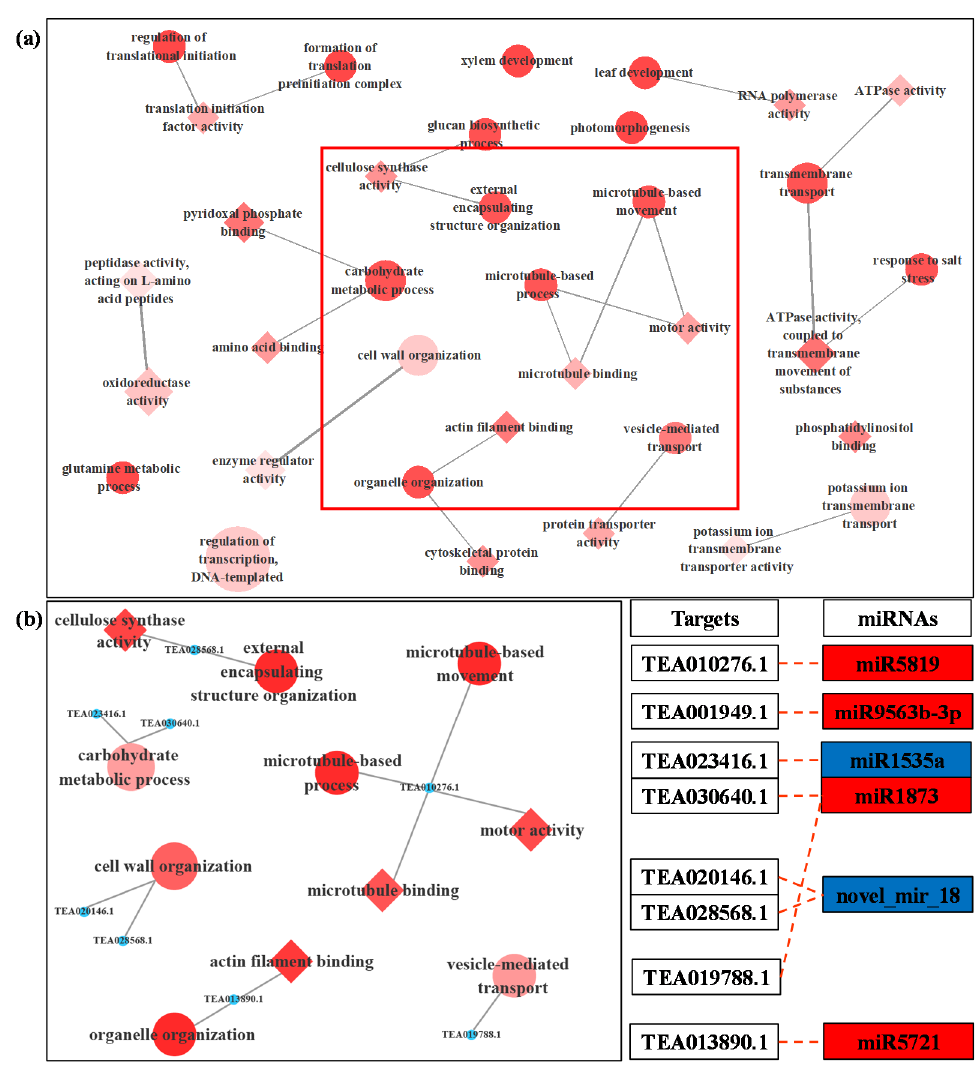
Figure 4. GO-GO network of the targeted genes of DEMs between LT (low-temperature) and CK (control) ( a ). Local amplification of GO-GO network related to microtubule and cell wall organization and its miRNA target ( b ). In the network, the circle represents the biological process term, and the diamond represents the molecular function term. The filling color of the GO term from white to red represents the enrichment degree (p.adjust) of the GO term. The color of the miRNA term indicates its regulation mode; red represents that miRNA is up-regulated in LT, and blue represents that miRNA is down-regulated in LT.